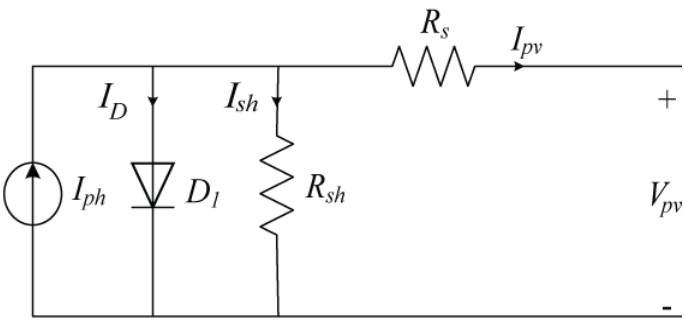
Figure 1. PV cell equivalent circuit.